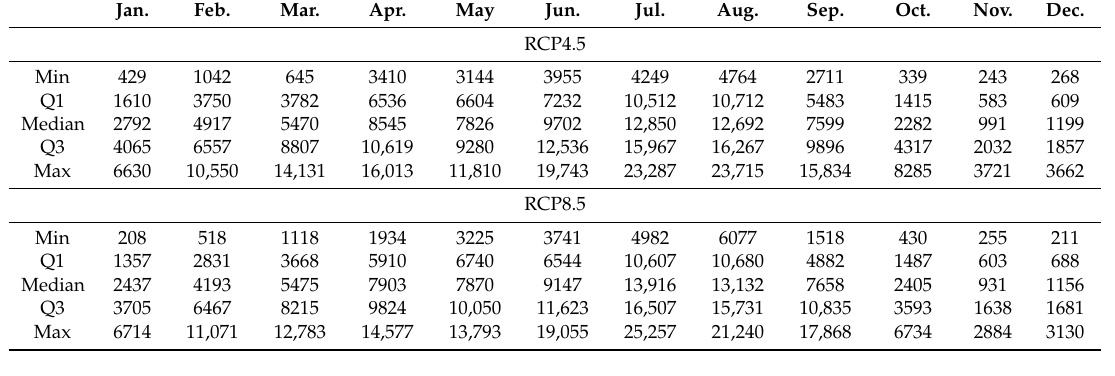
Table 1. Statistics for projected monthly flow simulations using the LXH model (unit: m 3 /s).